Question: In a single sentence, describe what this figure presents.
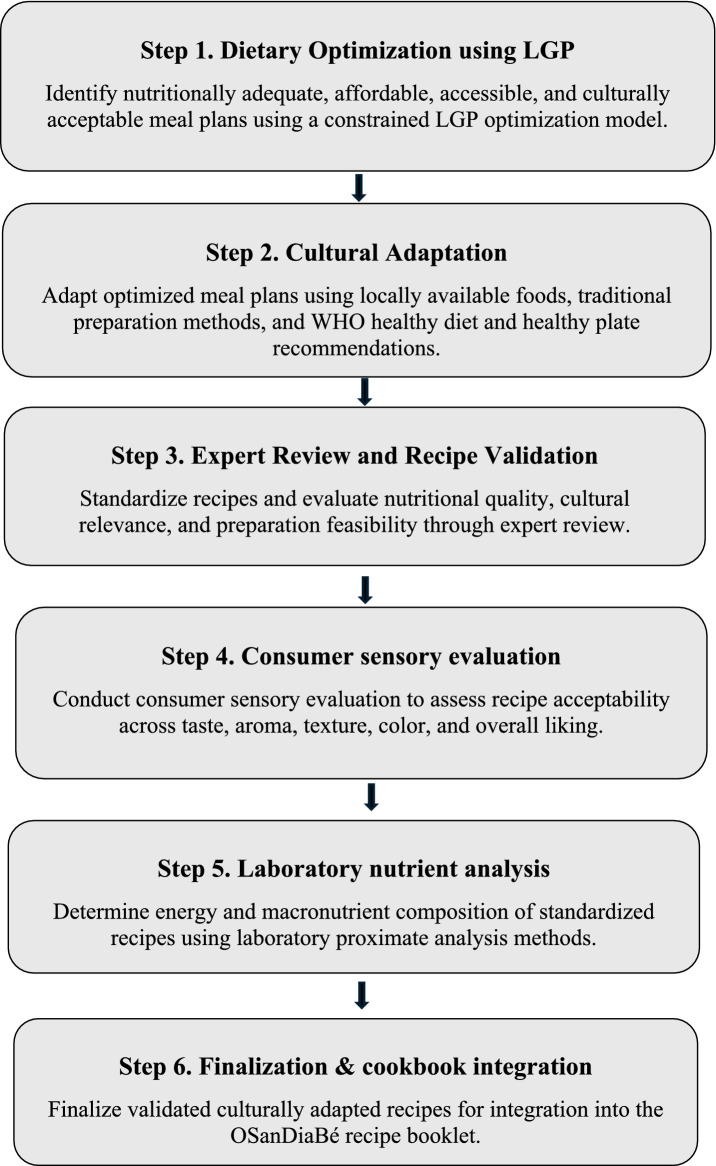
Answer: Six-step workflow for adapting and evaluating culturally appropriate recipes for individuals with type 2 diabetes (T2D), including nutritional optimization, expert validation, sensory testing, and nutrient analysis.